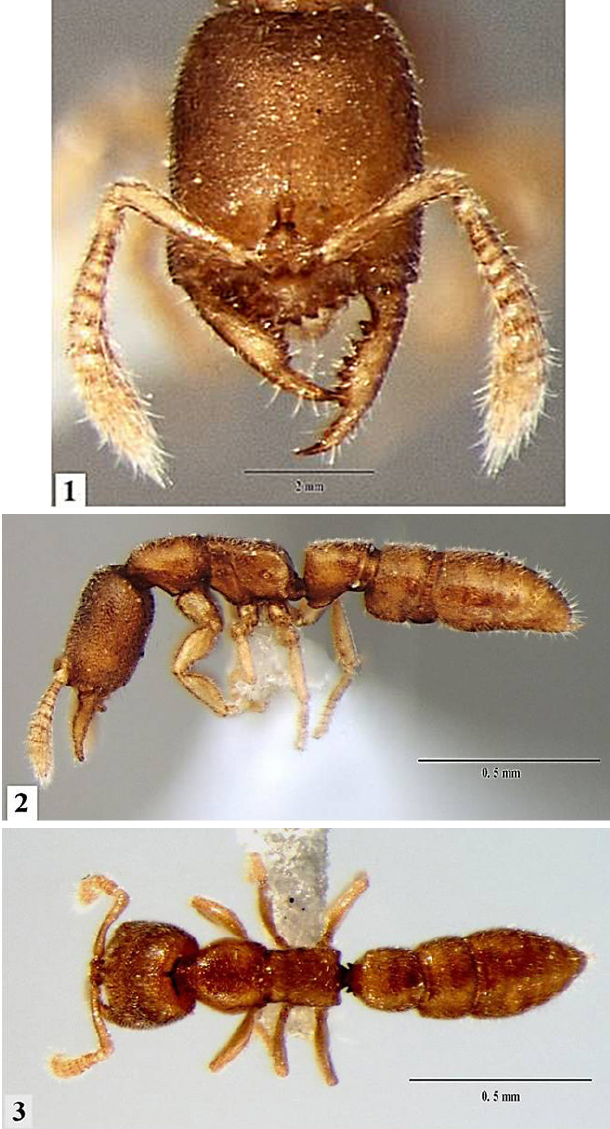
Fig 1-3. Stigmatomma xui sp. n.(worker): 1 . Head in full face-veiw; 2. Body in profile veiw; 3. Body in dorsal